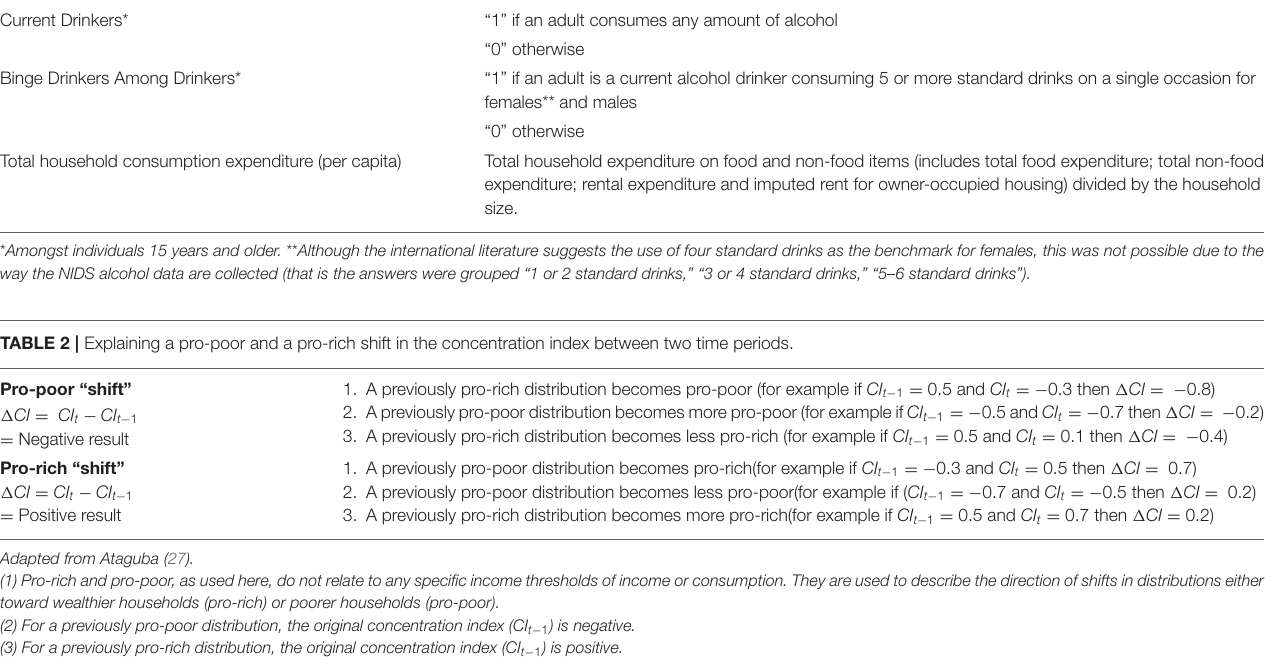
TABLE 1 | Description of key variables. Variables